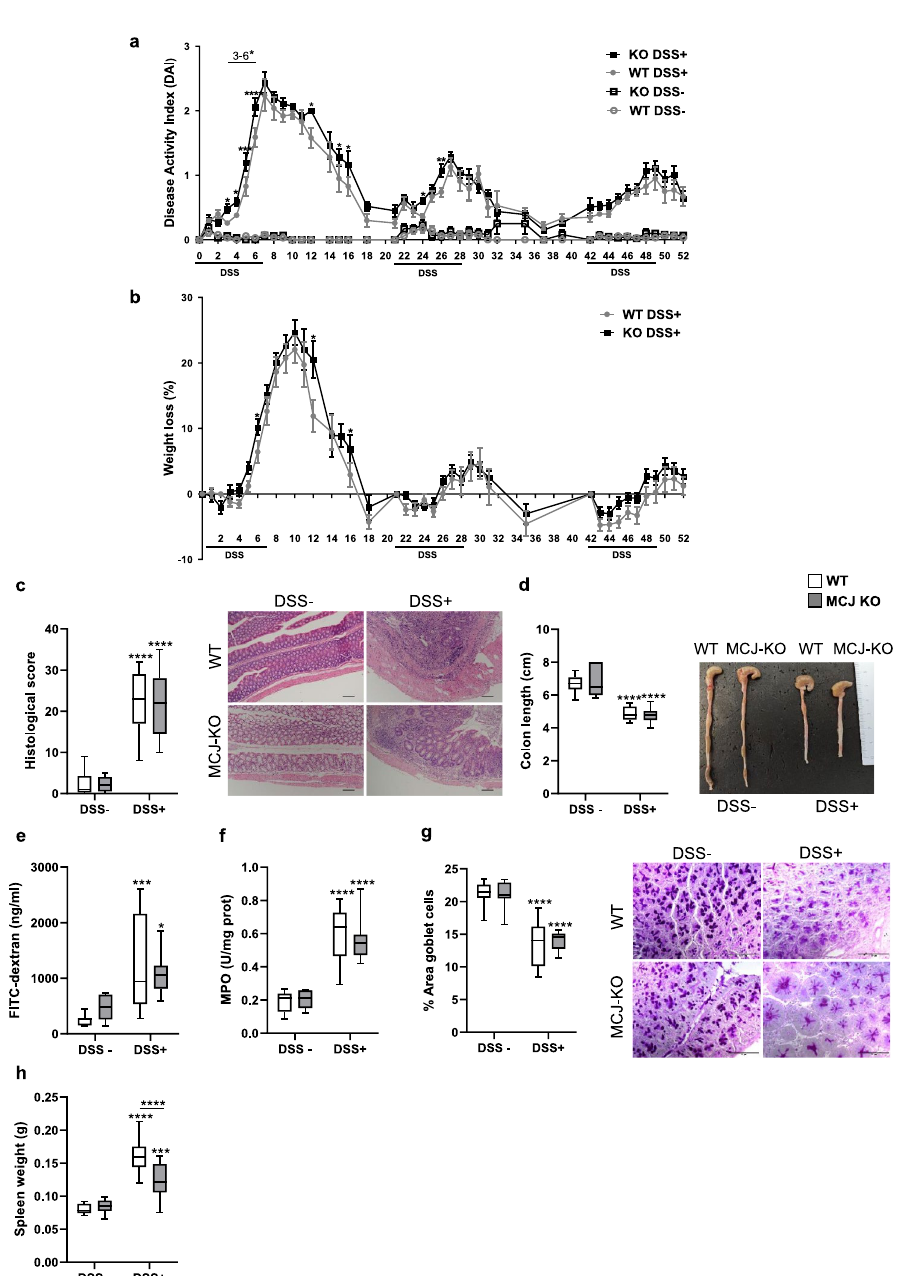
Figure 1. Characterization of DSS-induced chronic colitis effect in MCJ-deficient mice. To induce chronic colitis, mice received 3 cycles of 2% DSS during 7 days with 15 days with water in between. In the last cycle of DSS mice were let 3 days with water to recover. ( a) Disease activity index and ( b) weight loss percentage; data are means ± SEM. ( c) Histological score and representative images of the colon tissue stained with hematoxylin and eosin (× 100). ( d) Colon length (cm) and representative images. ( e) Permeability to the tracer FITC- dextran (ng/ml). ( f) Myeloperoxidase activity (U/mg prot). ( g) Goblet cells: % of positive cells stained with PAS (Periodic Acid-Schiff) and representative images of the stained colon tissue (× 400, scale bar = 100 μm). ( h) Spleen weight (g). Grey lines and white boxplots indicate WT and black lines and grey boxplots MCJ-KO mice. Box whisker plots of median, quartiles and range with at least 9 mice per group. For statistical analysis, two-way ANOVA was used as applicable, * P < 0.05, ** P < 0.01, *** P < 0.001, **** P < 0.0001. “*” above boxes versus control genotype (DSS + versus DSS-), “*” above line versus different genotypes in the same experimental